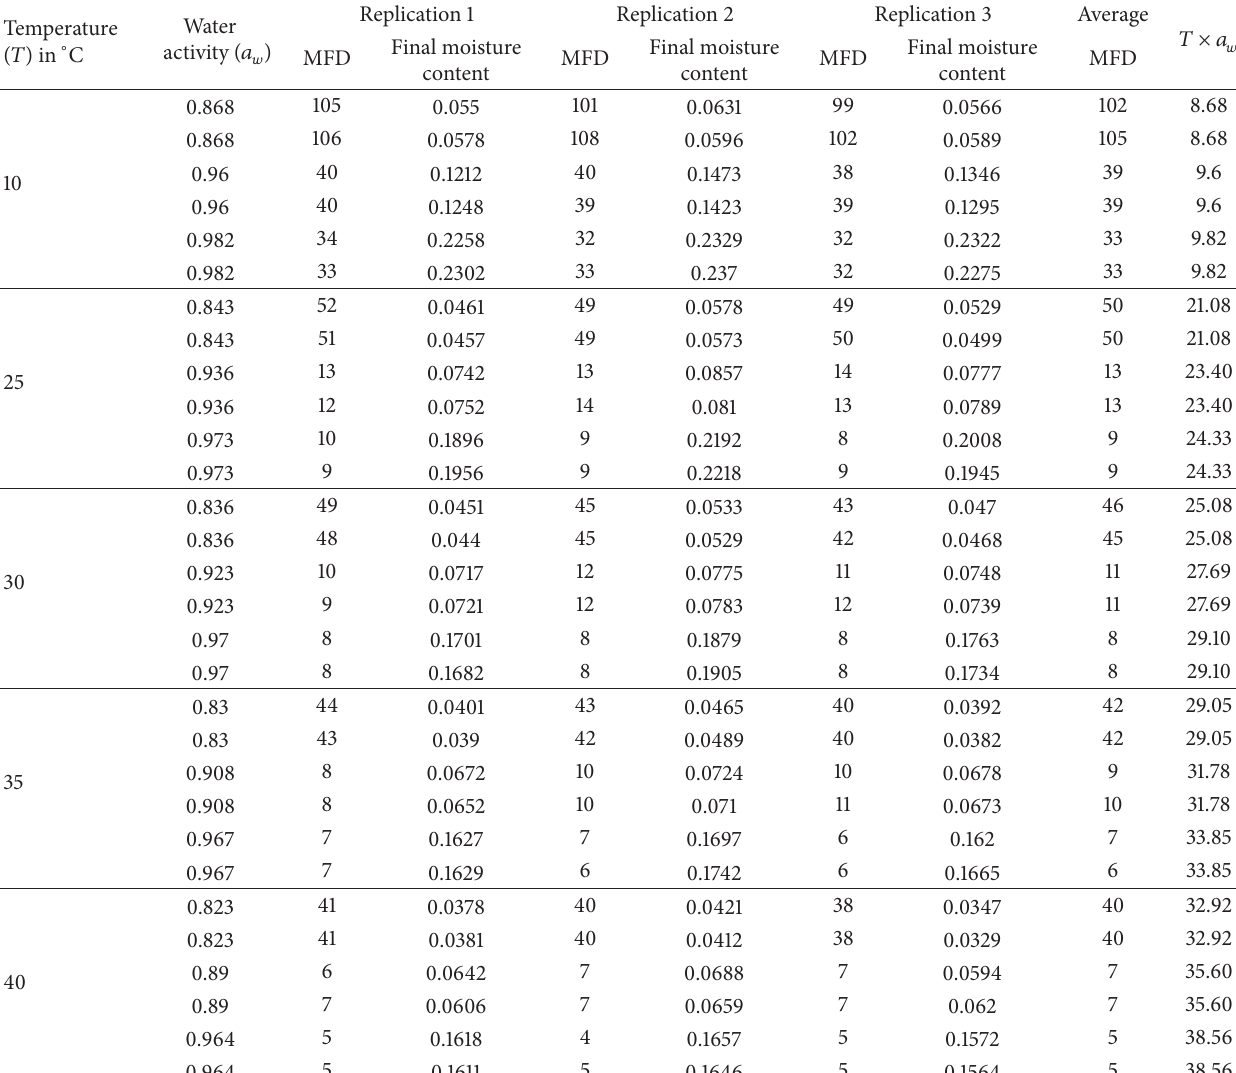
Table 2: Mold-free days (MFD) for soy/PE fiber samples held at different temperatures and water activities.